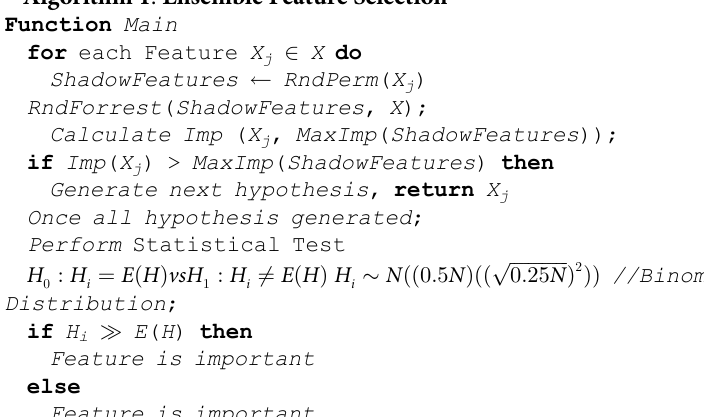
Algorithm 1 : Ensemble Feature Selection